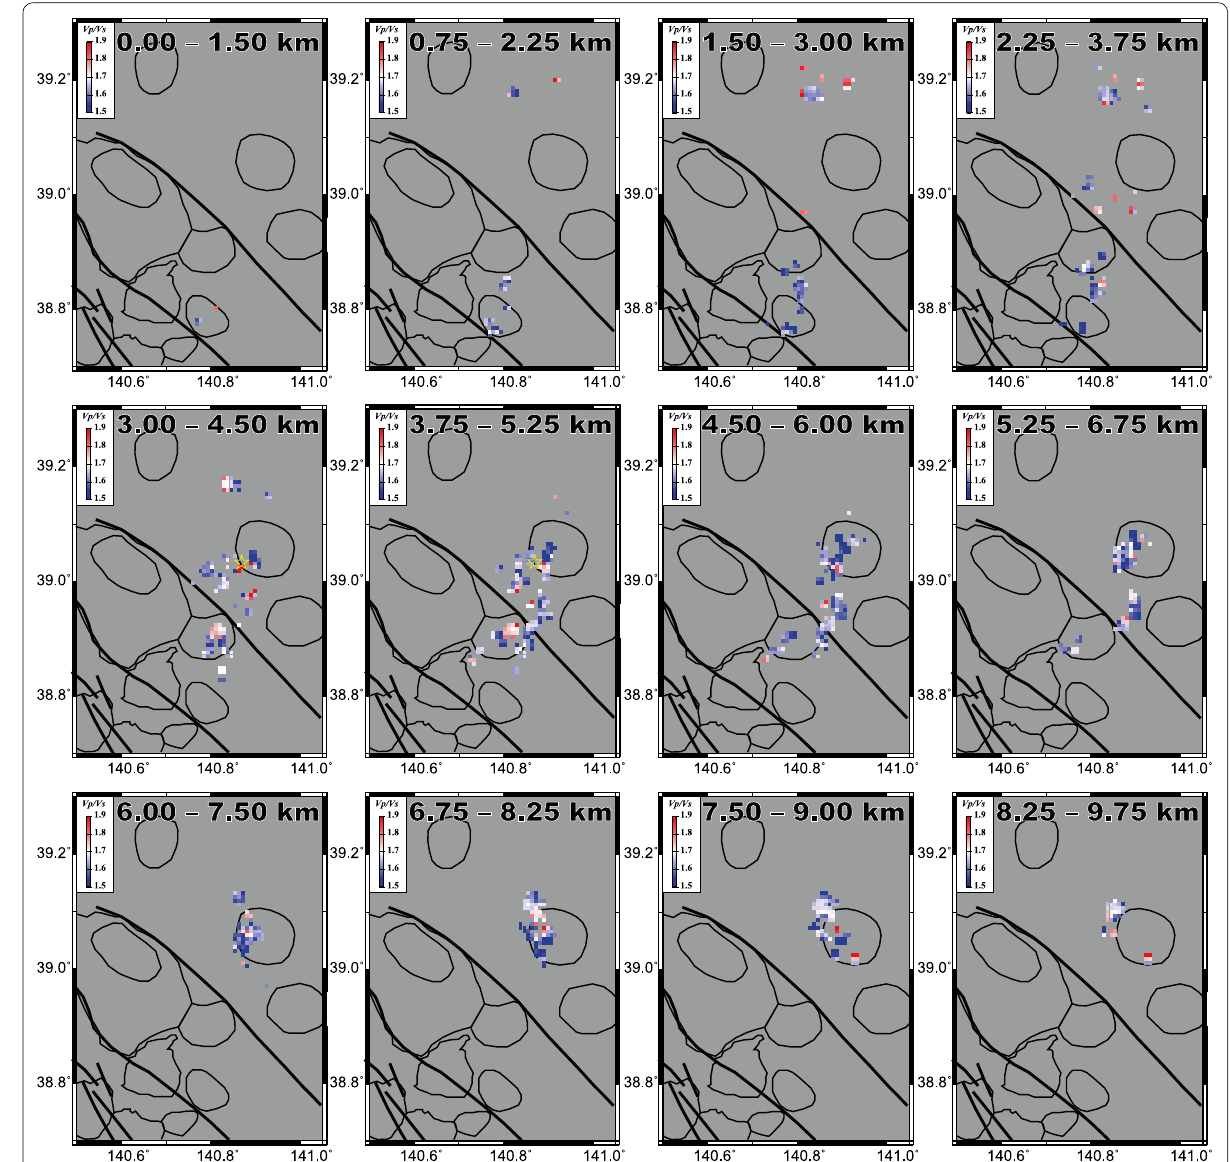
Fig. 5 V p /V s distribution estimated in this study. The yellow star denotes the mainshock epicenter estimated by Okada et al. (2012). See the caption of Fig. 1 and the text for calderas and tectonic